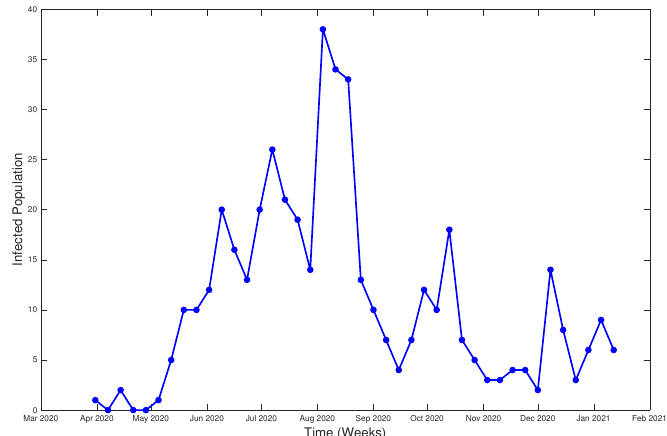
Figure 22. Infected from March 2020 to January 2021, Olmué city